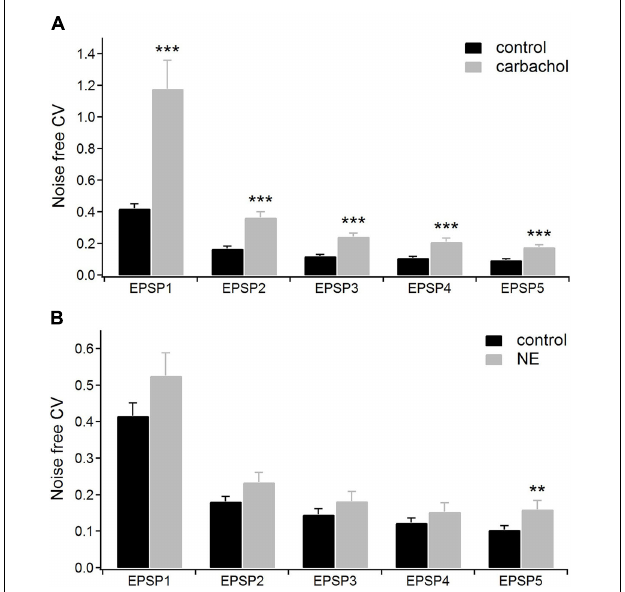
FIGURE 4 | The coefficients of variations (CV) analysis. (A) Mean CV values ( n = 16) for consecutive EPSPs of the train in the control condition (with ACSF containing GABA inhibitors) and after application of 6–8 µ M carbachol. (B) Mean CV values ( n = 15) for the consecutive EPSPs in the control condition (with ACSF containing GABA inhibitors plus ascorbic acid) and after application of 100 µ M norepinephrine. Data are expressed as mean ± SEM, *** P ≤ 0.001, ** P ≤